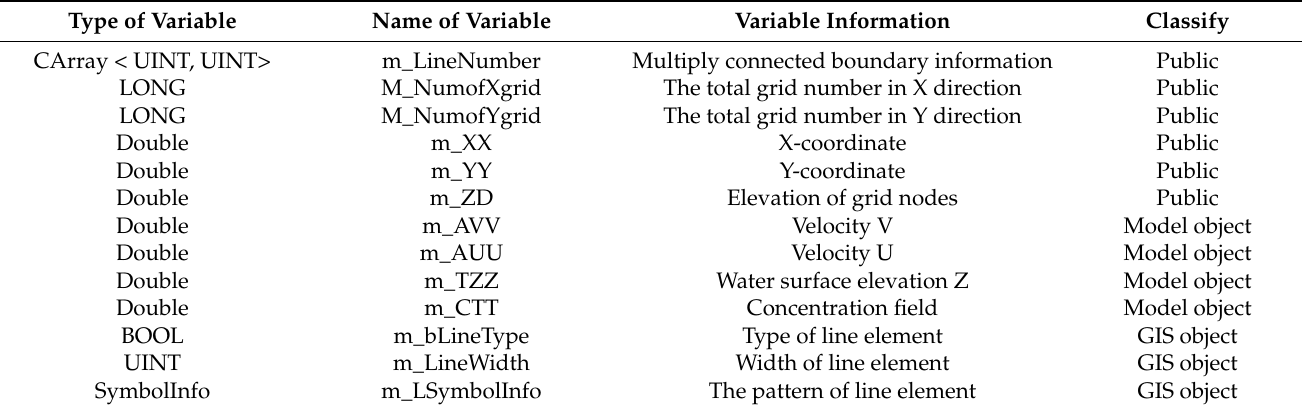
Table 2. Parameters of the two-dimensional river model.